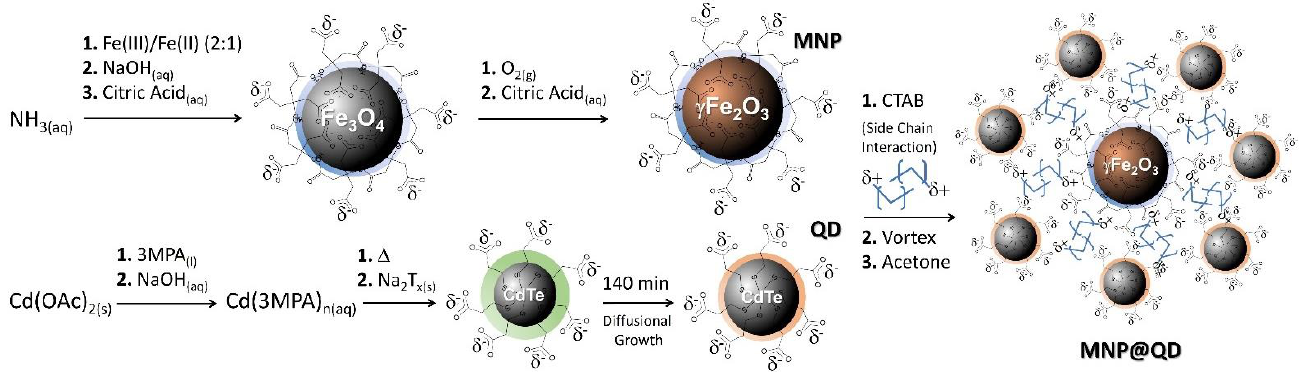
Figure 1. Illustrative representation of citrate-functionalized maghemite nanoparticles (MNP) and fluorescent water-based cadmium telluride quantum dots (QD) synthesis and its assembling with cetyltrimethylammonium bromide (CTAB) by electrostatic and side chain interactions.